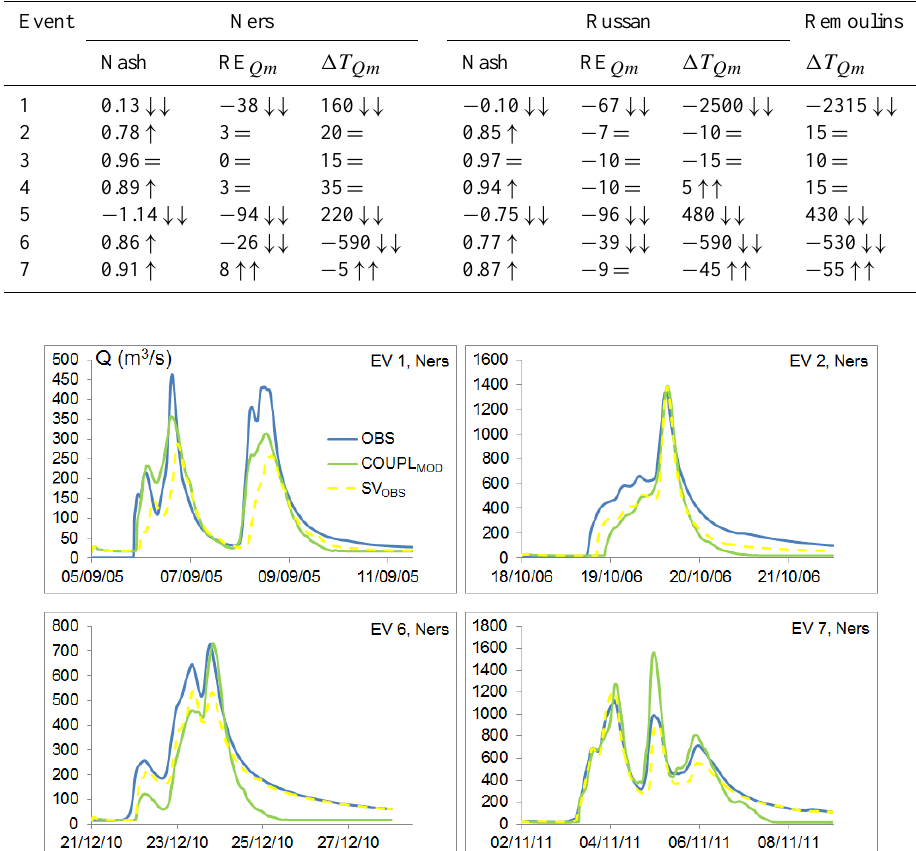
Figure 8. Hydrographs modelled for event nos. 1, 2, 6 and 7 according to the COUPL MOD and SV OBS modelling options, at the Ners station.